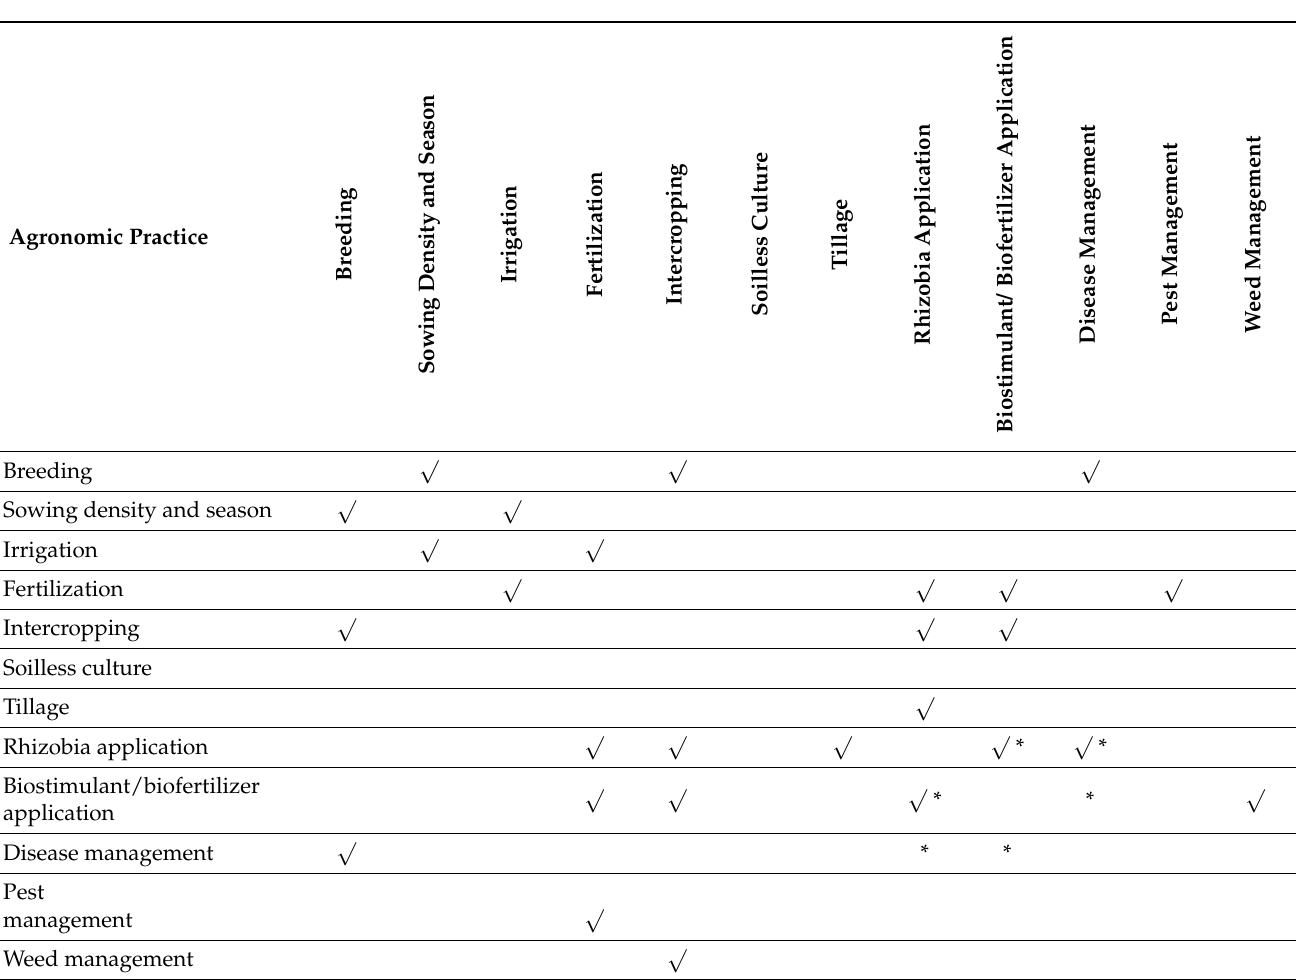
Table 2. Studies reporting results from two or three agronomic practices. The studies and * denotes the one triplicate